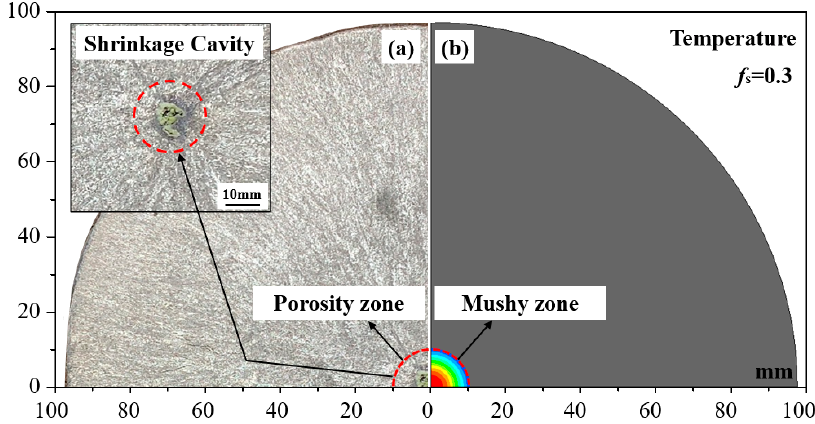
Figure 5. ( a ) Porosity zone in practice, ( b ) Mushy zone in simulation.